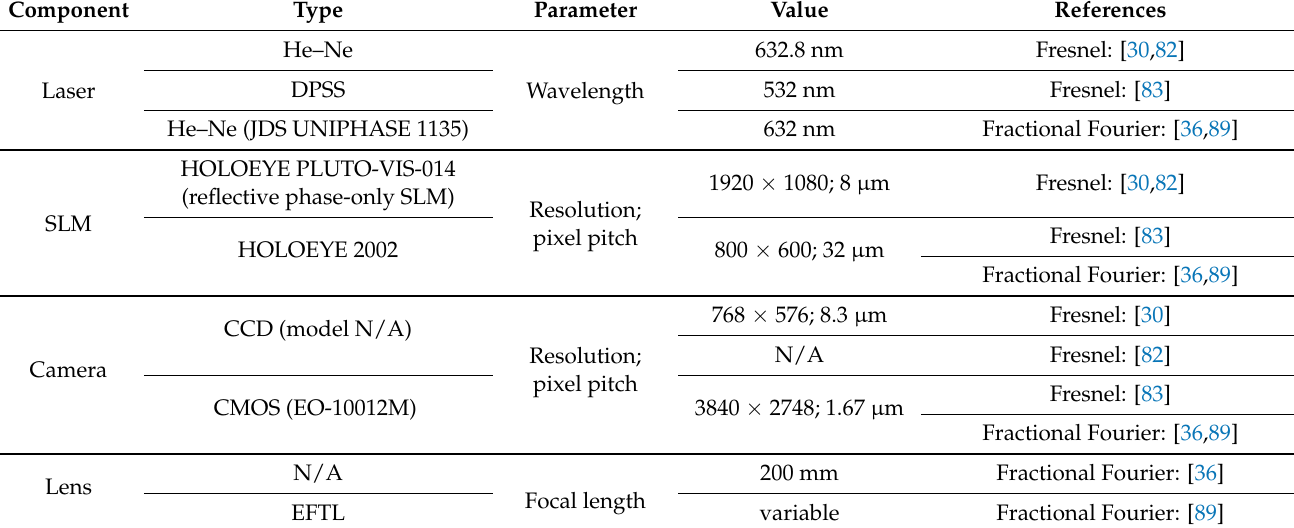
Table 2. Comparison between the most important parameters of the JTC setup in various proposed architectures, other than the Fourier transform-based